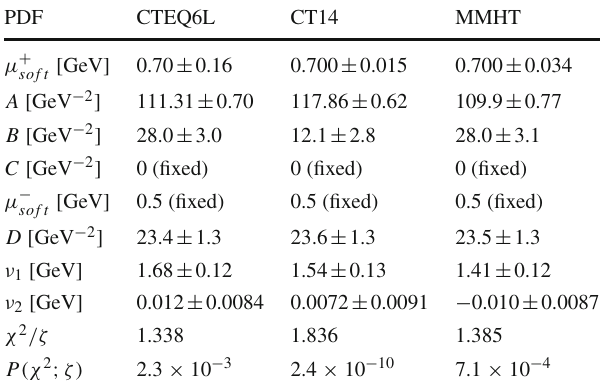
Table 4 Best-fit parameters of our model, obtained by fixing C =